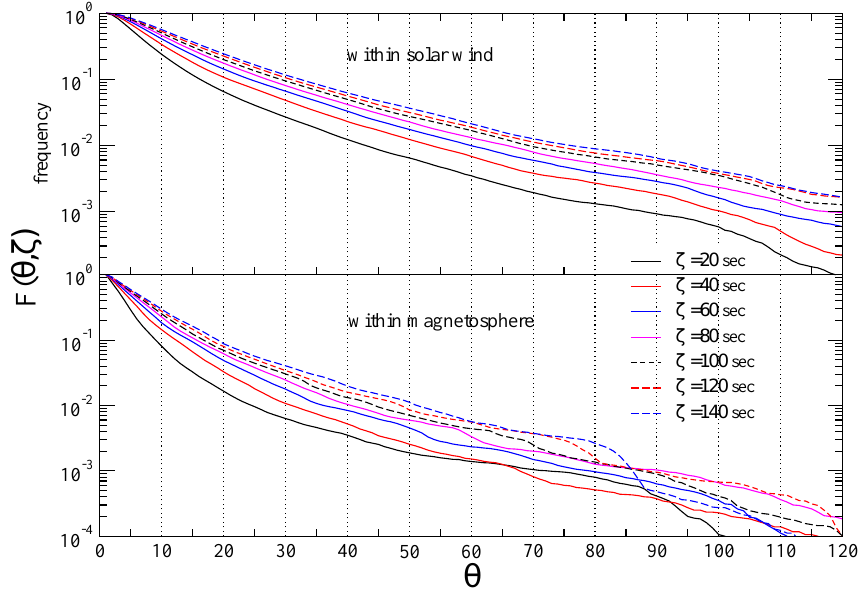
Fig. 2. F(θ,ζ) as function of θ . The upper panel is during period A, when Cluster C1 is in the solar wind. The lower panel is during period B, when Cluster C1 is inside Earth’s magnetotail. Curves for seven ζ values are shown. See text.